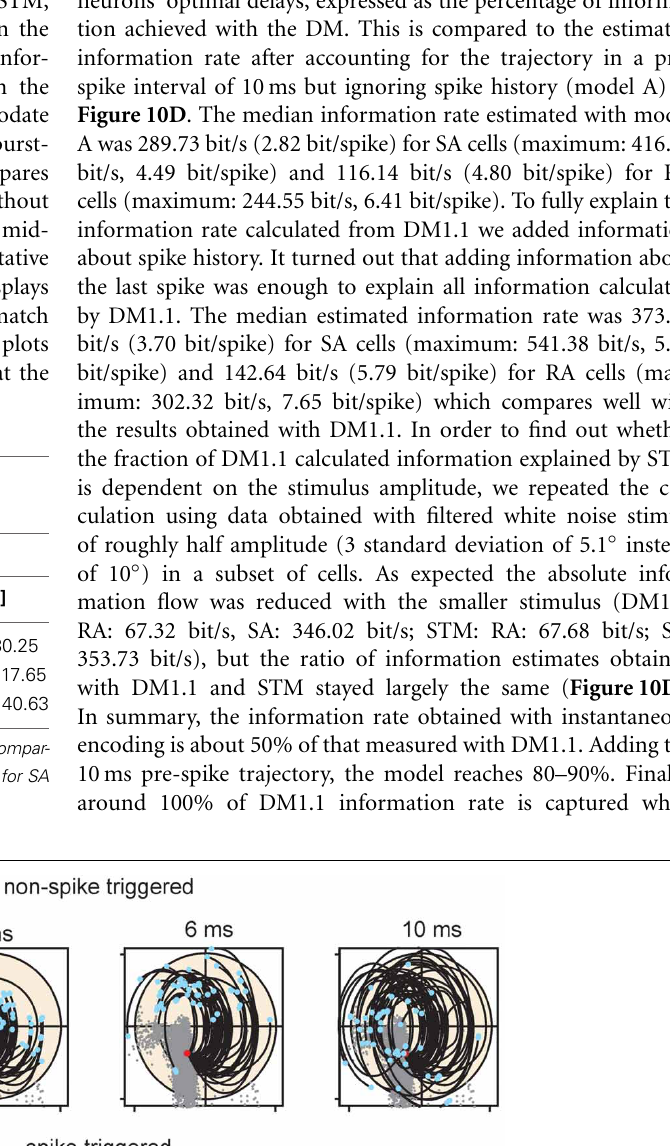
gray dots in all graphs. Top row: Trajectories that did not evoke a spike. Bottom row: Trajectories that evoked a spike. All dots (gray, red, and blue) account for the optimal delay of the cell (cf. Figure 3 ). The duration of the trajectories is indicated above the graphs. Spike triggered trajectories (bottom) are more confined in the stimulus space as compared to the non-spike triggered ones (top), suggesting that the spikes carry trajectory